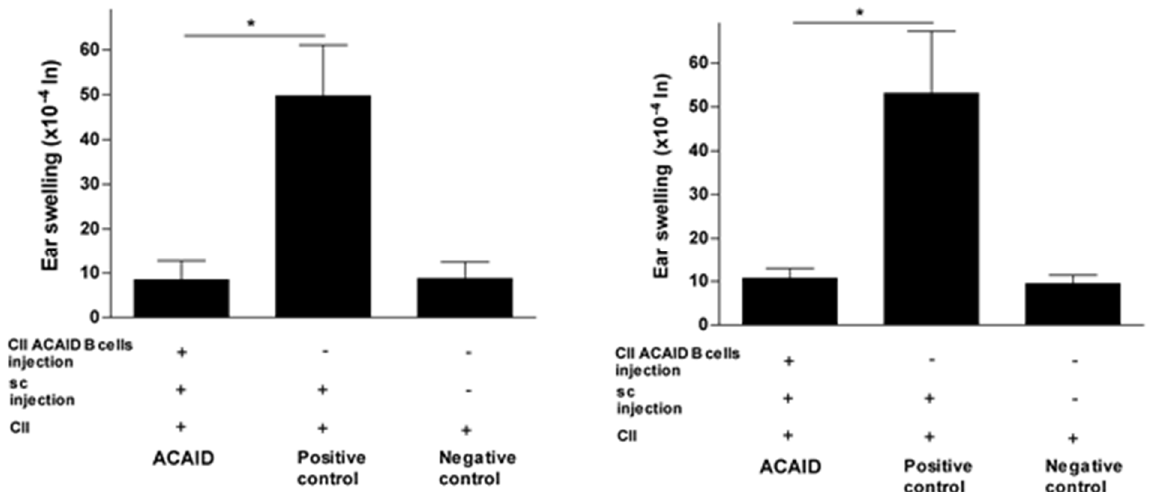
Figure 1. In vitro generated type II collagen (CII)-specific anterior chamber-associated immune deviation (ACAID) B cells inhibited CII-induced delayed hypersensitivity (DTH) responses in BALB/c mice. The in vitro generation of CII-specific ACAID B cells and the DTH assay were described in the Materials and Methods section. CII-specific ACAID B cells were intravenously injected to induce ACAID followed by subcutaneous immunization with CII/CFA on day 7. On day 14, mice were challenged with CII (500 µg in 20 µL) intradermally in the left ear pinna, and 20 µL of acetic acid alone was injected into the right ear pinna as an internal control. ACAID induction was confirmed by suppression of ear swelling responses after 24 h (left panel) and 48 h (right panel). The positive control mice were subcutaneously immunized with CII/CFA on day 7 and with CII on day 14, whereas the negative control mice only received intradermal injection of CII on day 14. * p < 0.05 were considered to be statistically significant.